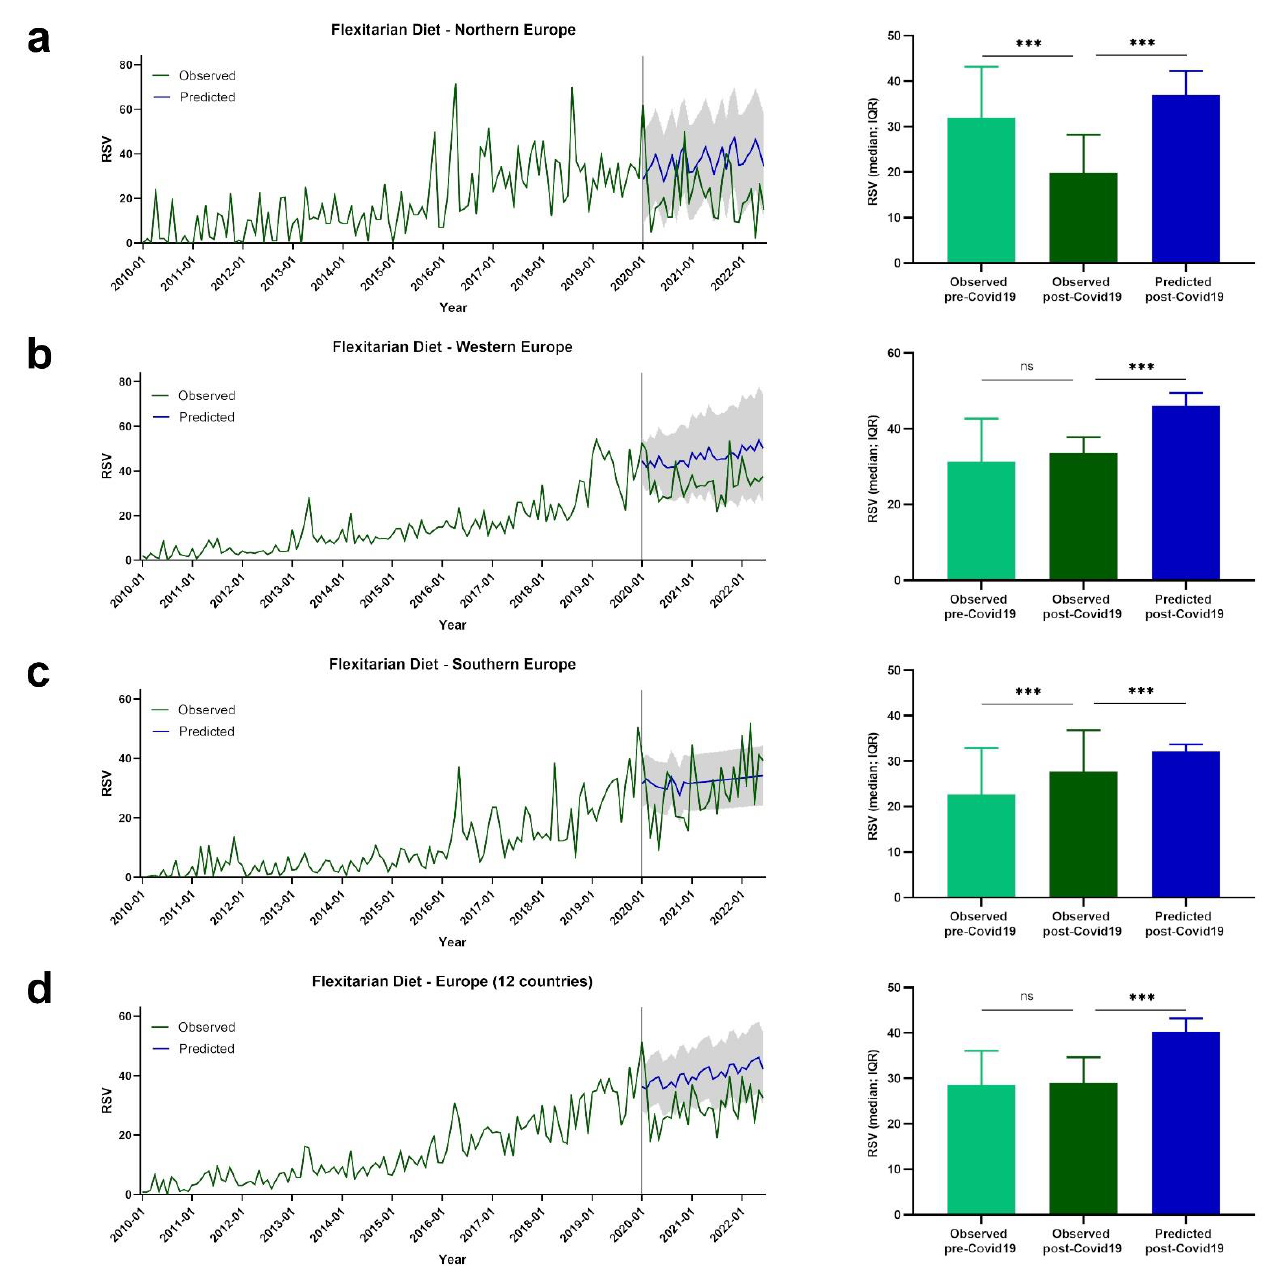
Figure 4. The RSV evolution for FlexDiet topic. ( a ) Evolution of RSVs for FlexDiet topic in northern Europe from January 2010 to June 2022 (green line), predicted evolution of RSVs for FlexDiet topic between January 2020 and June 2022 (blue line); gray shadow represents 95% confidence interval. ( b ) Evolution of RSVs for FlexDiet topic in western Europe from January 2010 to June 2022 (green line), predicted evolution of RSVs for FlexDiet topic between January 2020 and June 2022 (blue line); gray shadow represents 95% confidence interval. ( c ) Evolution of RSVs for FlexDiet topic in southern Europe from January 2010 to June 2022 (green line), predicted evolution of RSVs for FlexDiet topic between January 2020 and June 2022 (blue line); gray shadow represents 95% confidence interval. ( d ) Evolution of RSVs for FlexDiet topic in Europe from January 2010 to June 2022 (green line), predicted evolution of RSVs for FlexDiet topic between January 2020 and June 2022 (blue line); gray shadow represents 95% confidence interval. For ( a – d ) bars represent the comparison between median RSVs pre-COVID-19 and post-COVID-19, and between post-COVID-19 and predicted post-COVID-19 data. *** p <.001; ns — not significant.